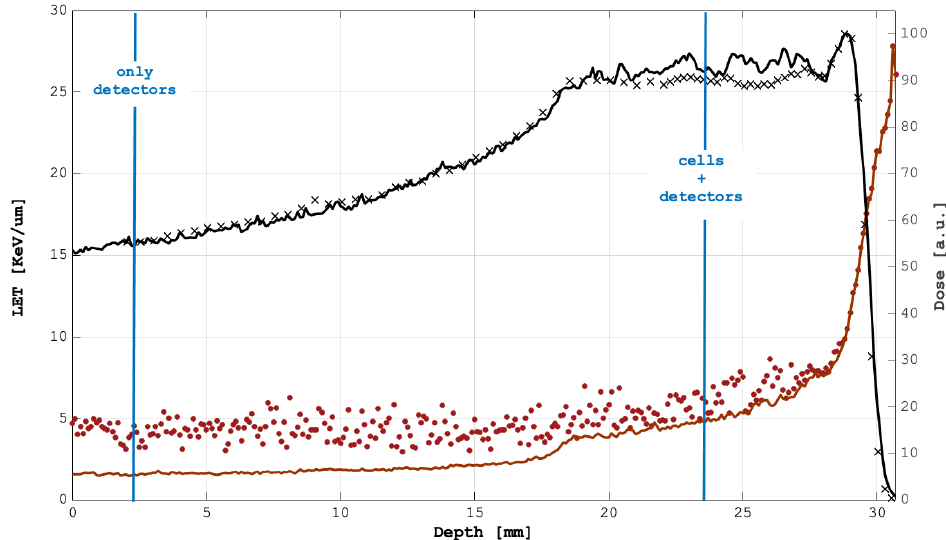
Figure 1. The relative dose measured with the Markus chamber (black crosses), simulated dose distribution (black line), primary LET-dose computed for only primary protons (red line) and LET-Total-dose considering also the contribution of generated secondary particles (red circles) are reported.The vertical blue lines show the positions at which measurements were performed. Simu- lated and measured values for the absorbed dose are in good agreement when a 2% uncertainty is considered in both sets of